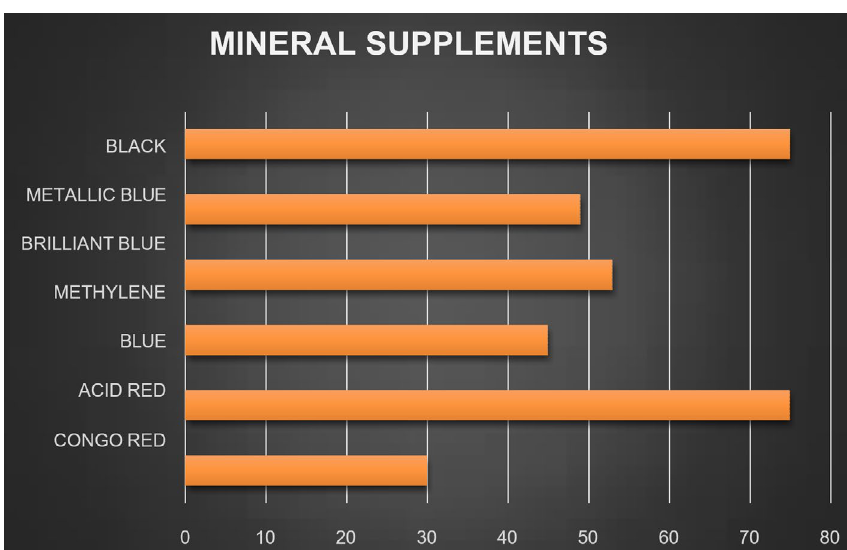
Fig. 11. Graphical Representation for Decolorization of the Dyes Statistical Representation of Degradation of the